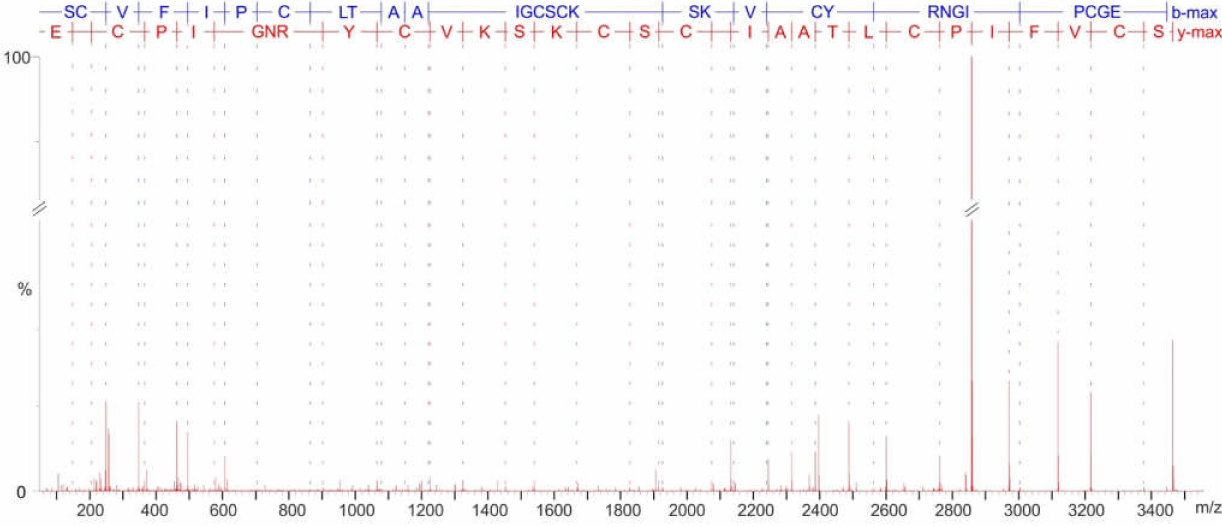
Figure 3. Peptide sequencing of the novel cyclotide (named viul M) produced in V. uliginosa cell suspension culture based on its MS/MS fragmentation spectrum. The isolated cyclotide was alkylated (carbamidomethylated cysteines) and digested with Glu-C endoprotease, resulting in a linear peptide subsequently analyzed with